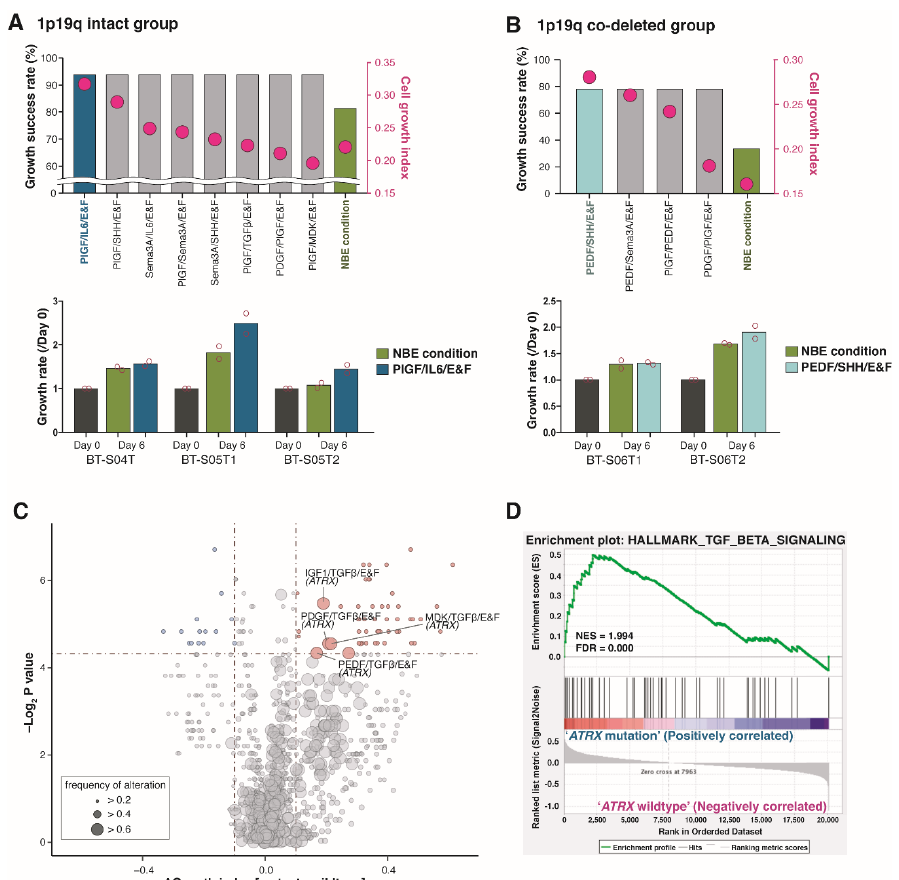
Figure 5. Newly selected culture conditions for IDH1 -mut DIGs. ( A , B ) The culture conditions with higher growth success rates than the NBE condition for the IDH1 -mut and 1p19q intact cells ( A ) and IDH1 -mut and 1p1 / 9q co-deleted cell ( B ) (upper panels). The bars and dots indicate growth success rates and cell growth indices, respectively. The culture condition with the highest growth success rate and highest cell growth index was validated in additional samples (lower panels). The dots represent the values from technical duplicates. ( C ) A volcano plot showing culture conditions with significant differences in cell growth indices between IDH1 -wt and -mut GSCs for frequently mutated genes in DIGs. The X-axis represents the magnitude (cell growth index of IDH1 -mut GSCs – that of IDH1 -wt GSCs), and the Y-axis represents the significance ( − log10(Wilcoxon rank-sum P -value)) of the association between mutations and culture conditions. Each circle represents a single mutation-culture condition interaction, and the size is proportional to the mutation frequencies. ( D ) The GSEA plot of transforming growth factor-beta (TGF- β )-associated gene set (HALLMARK_TGF_BETA_SIGNALING) between ATRX -mut and -wt GSCs in IDH1 -mut DIGs from the TCGA LGG